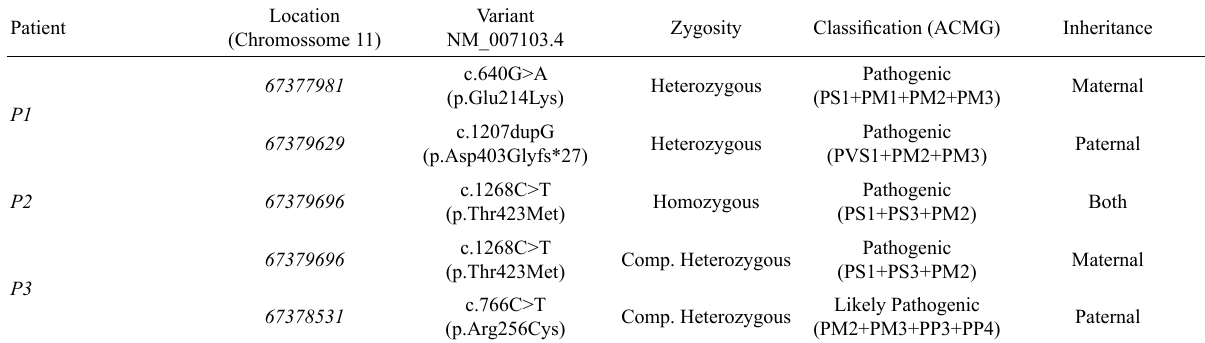
Table 2 ‒ Classification of the variants identified in P1, P2, and P3 according to the ACMG criteria.